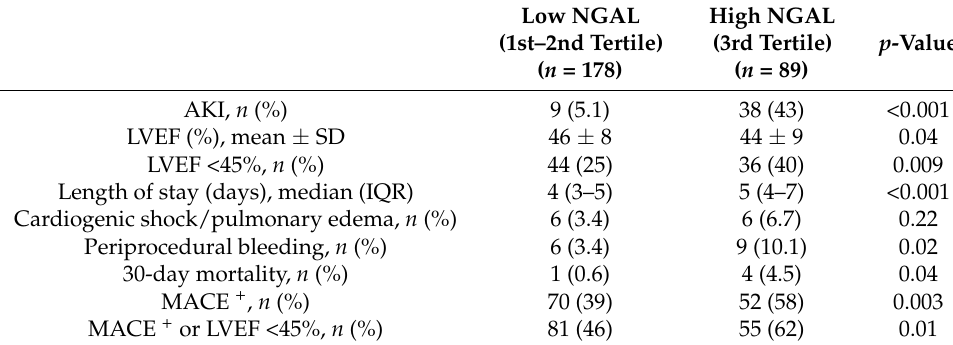
Table 3. Adverse short-term outcomes stratified by NGAL levels.